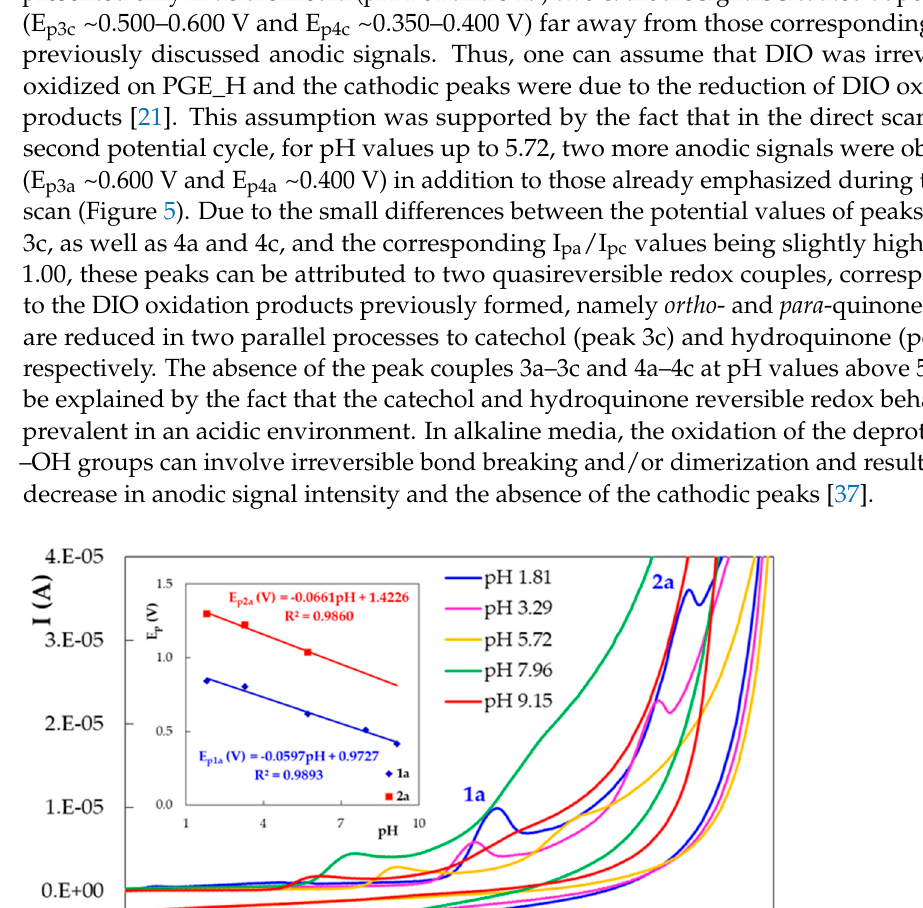
(Figure 4 inset). At the reversed scan of the first potential cycle, DIO cyclic voltammograms presented only in acidic media (pH 1.81 and 3.29) two cathodic signals situated at potentials (E p3c ~0.500–0.600 V and E p4c ~0.350–0.400 V) far away from those corresponding to the